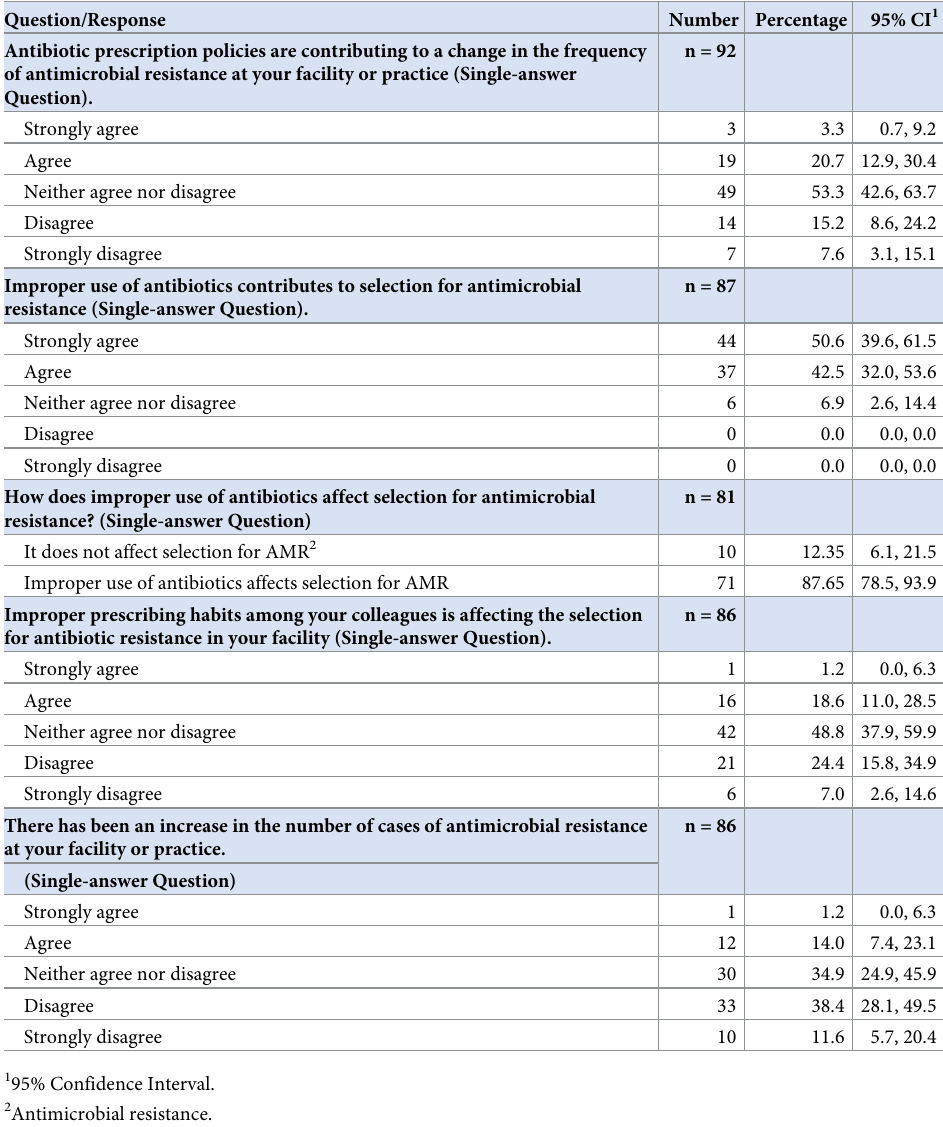
Table 4. Opinions, of veterinarians in Kentucky, on the role of antimicrobial use on development of antimicrobial resistance, 2017.